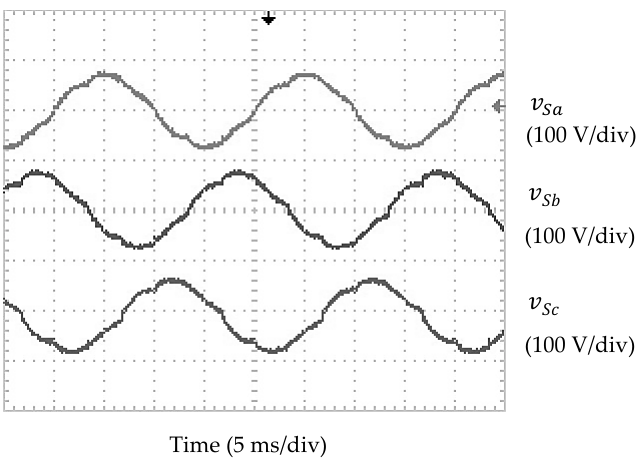
Figure 9. Experimental setup for the proposed shunt active power filter (SAPF).